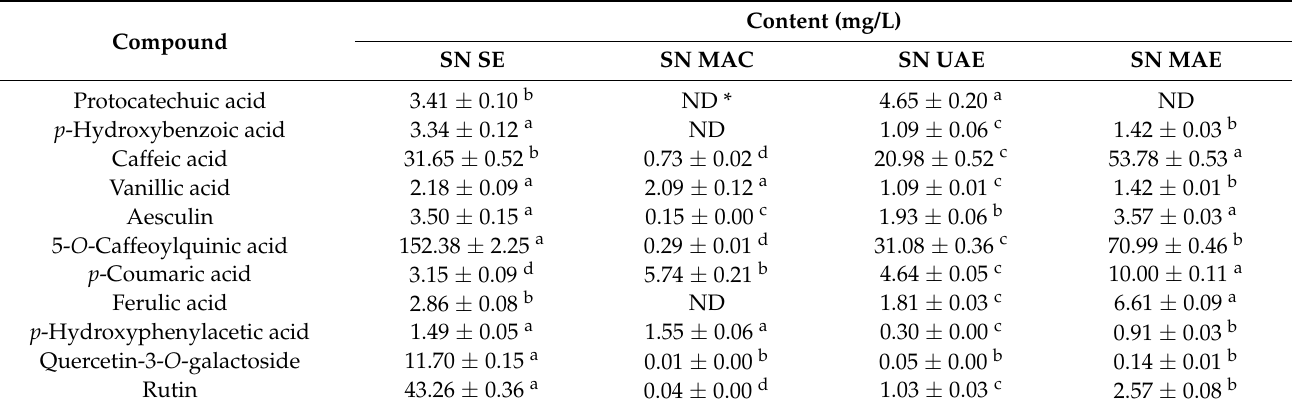
Table 1. Phenolic profile of different extracts obtained from stinging nettle